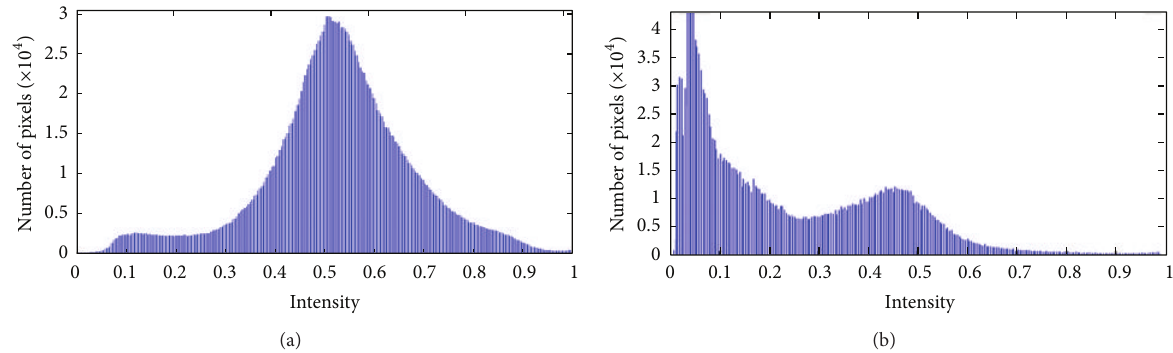
Figure 3: Histograms corresponding to color image of Figure 1 in (a) grayscale image and (b) saturation plane.